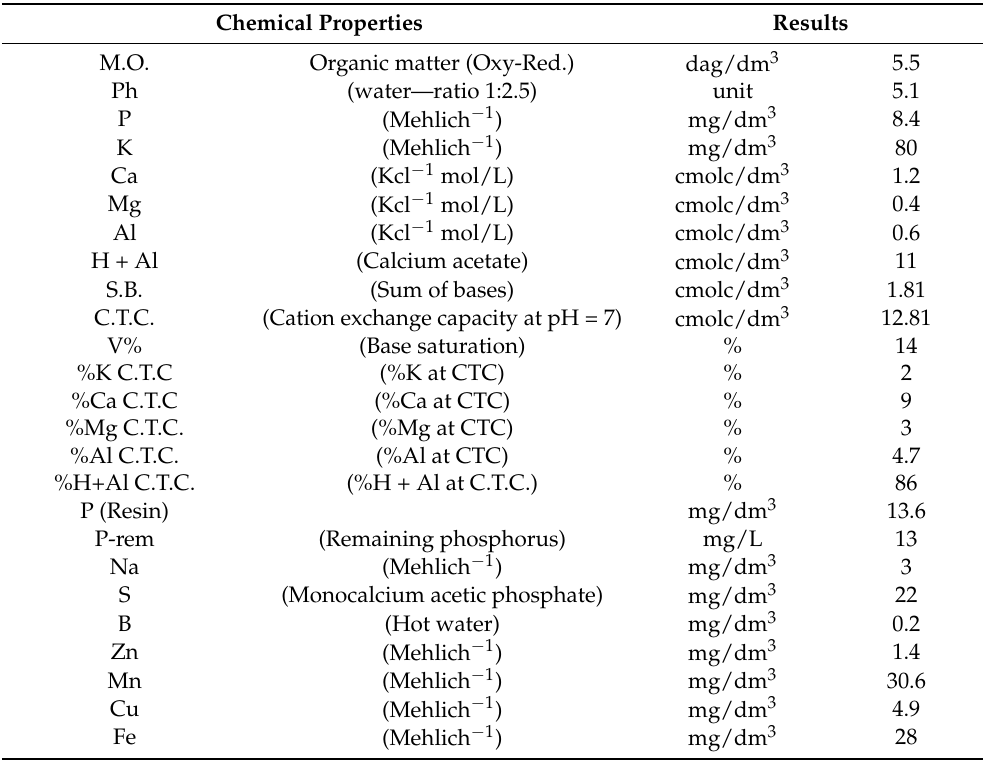
Table 1. Chemical and granulometric characteristics of the soil of the experimental area of Gorongosa Mountain, Gorongosa National Park, Sofala,